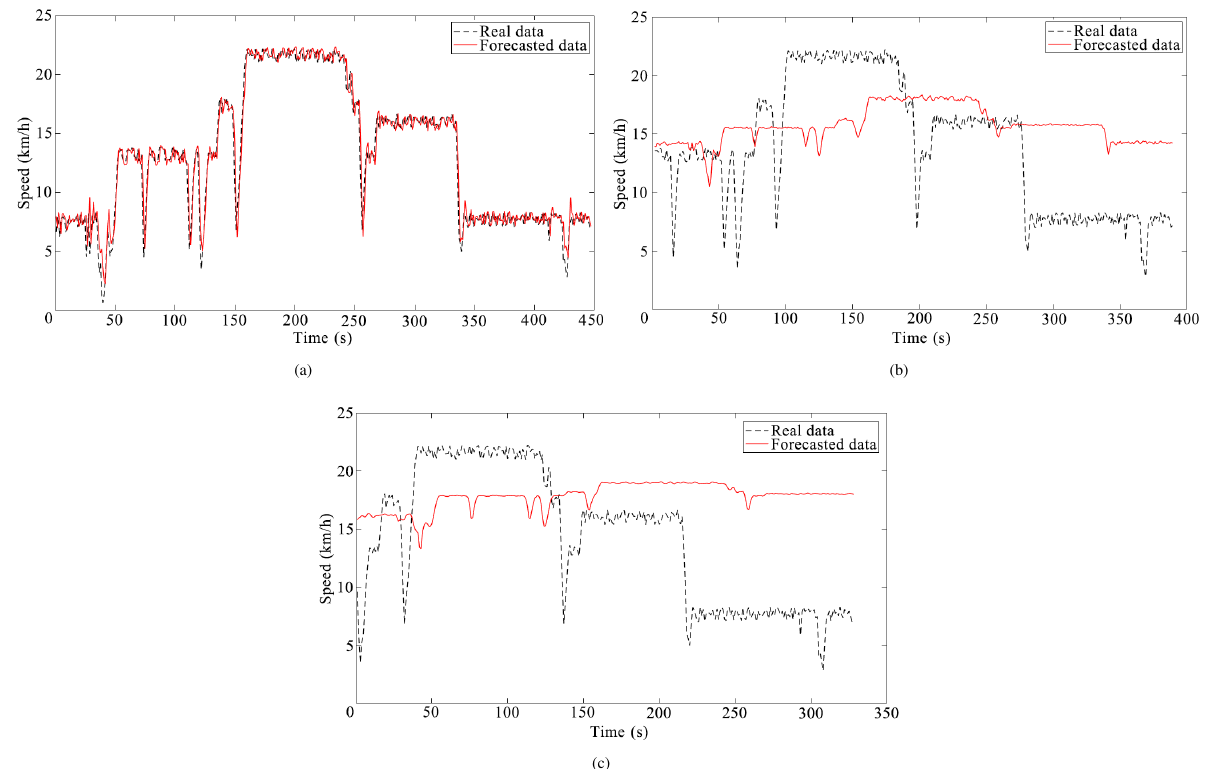
Fig. 3 EV speed forecasting results for the univariate LSTM model, (a) one step, (b) 60 steps, and (c) 120